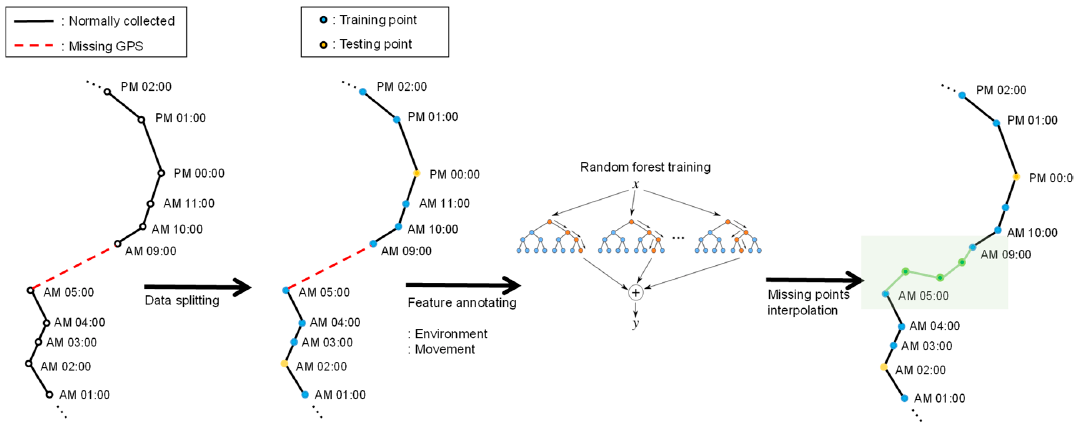
Figure 3. Movement interpolation using the random forest method.